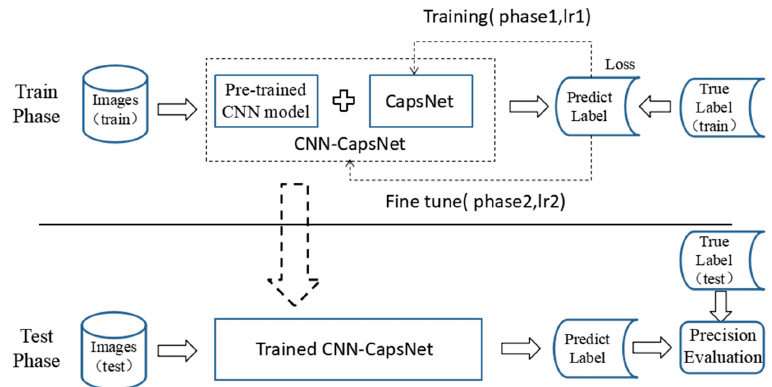
Figure 11. The flowchart of the proposed method.